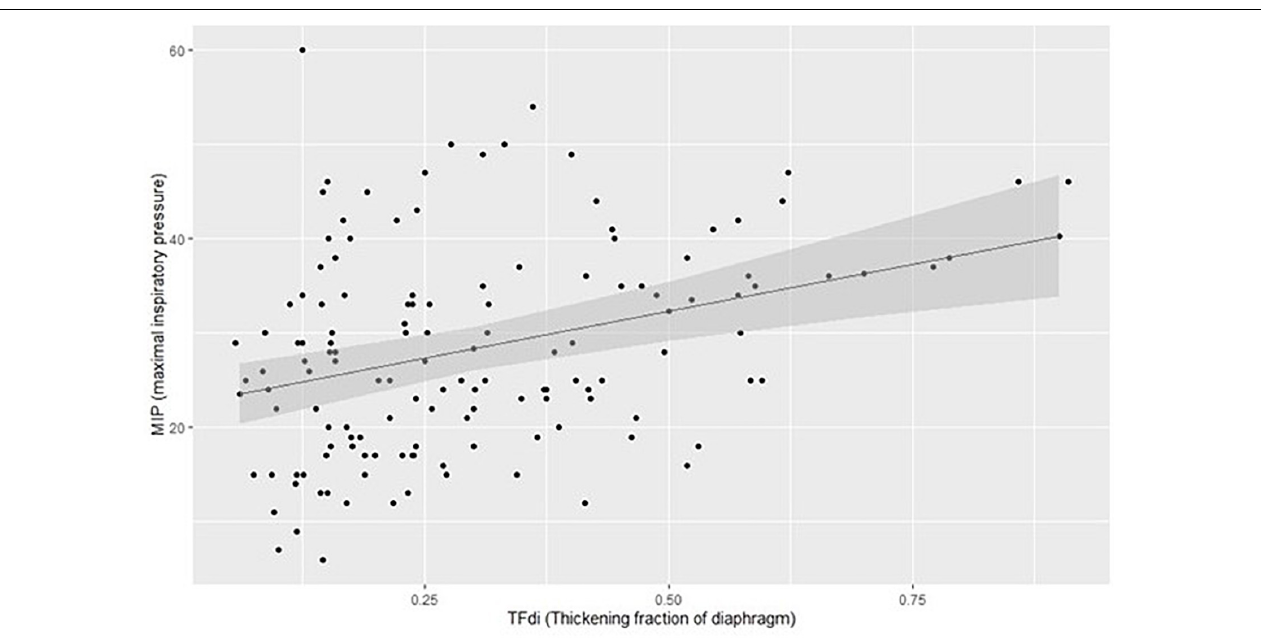
FIGURE 3 | Plotting of model estimates of the correlation between MIP (maximal inspiratory pressure) and TFdi (thickening fraction of